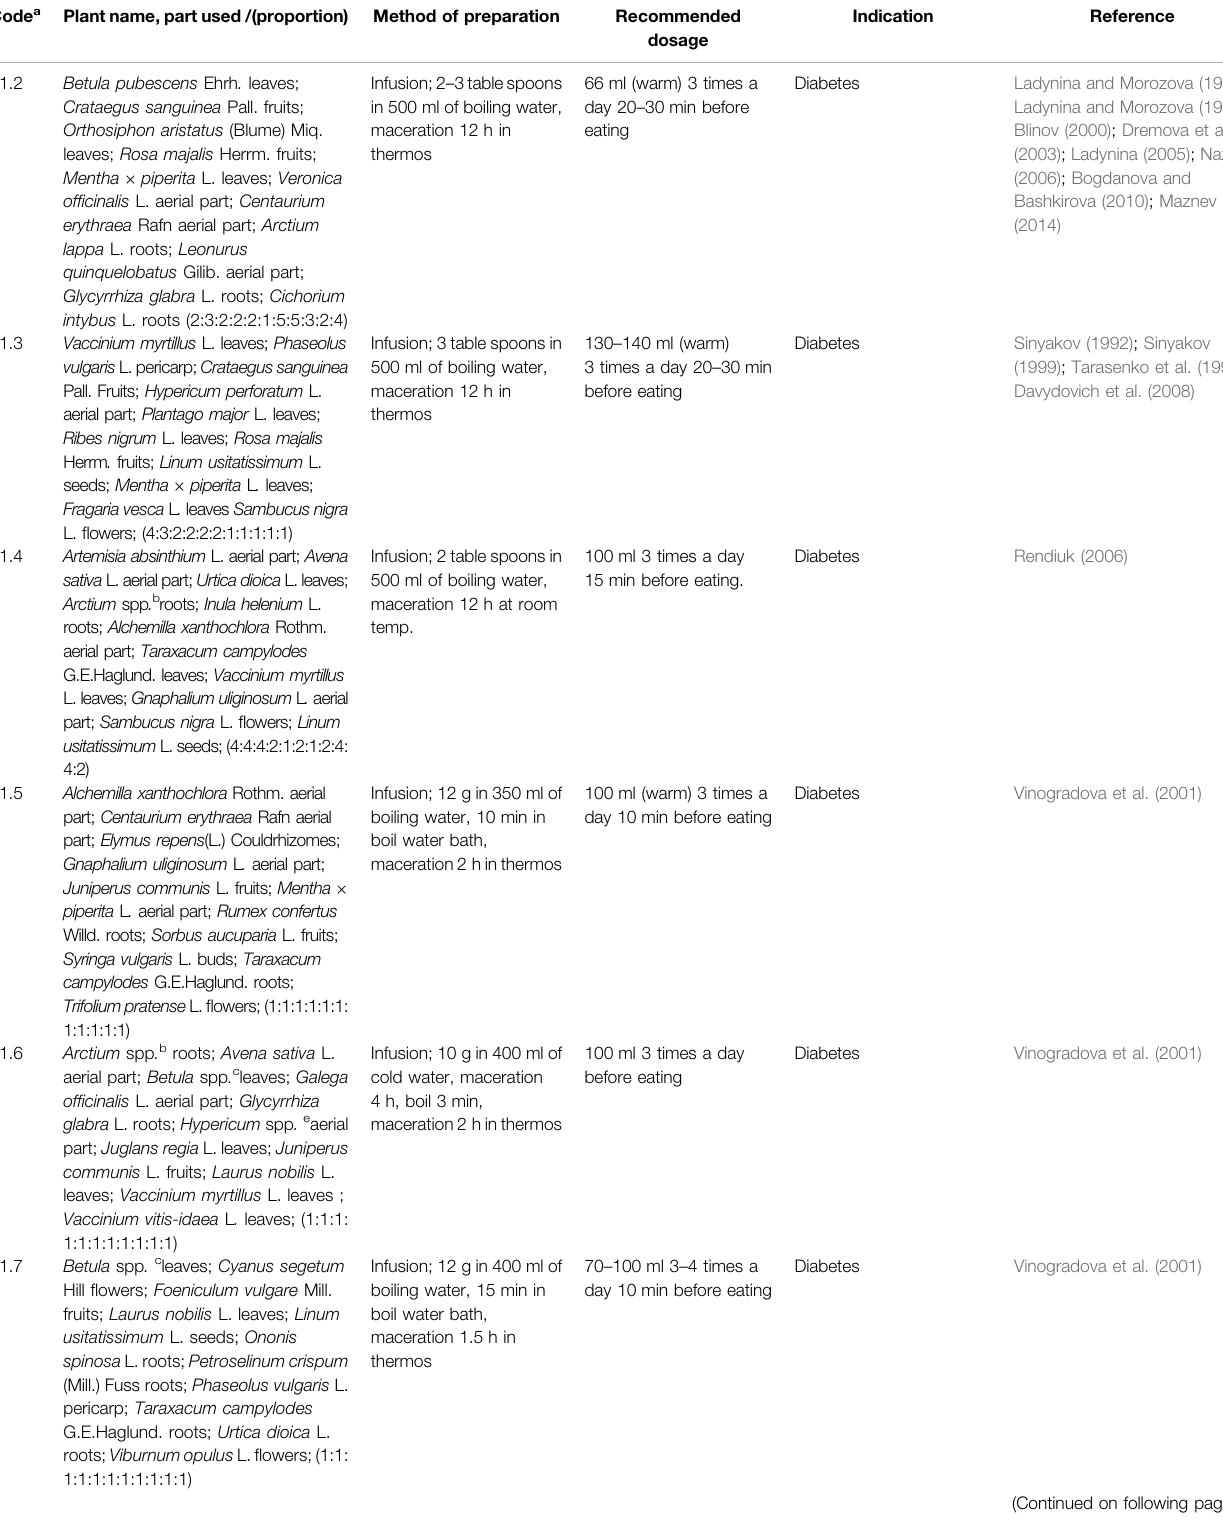
TABLE 1 | ( Continued ) The list of medical species used for the management of diabetes and related disorders in Russia. Code a Plant name, part used /(proportion) Method of preparation Recommended